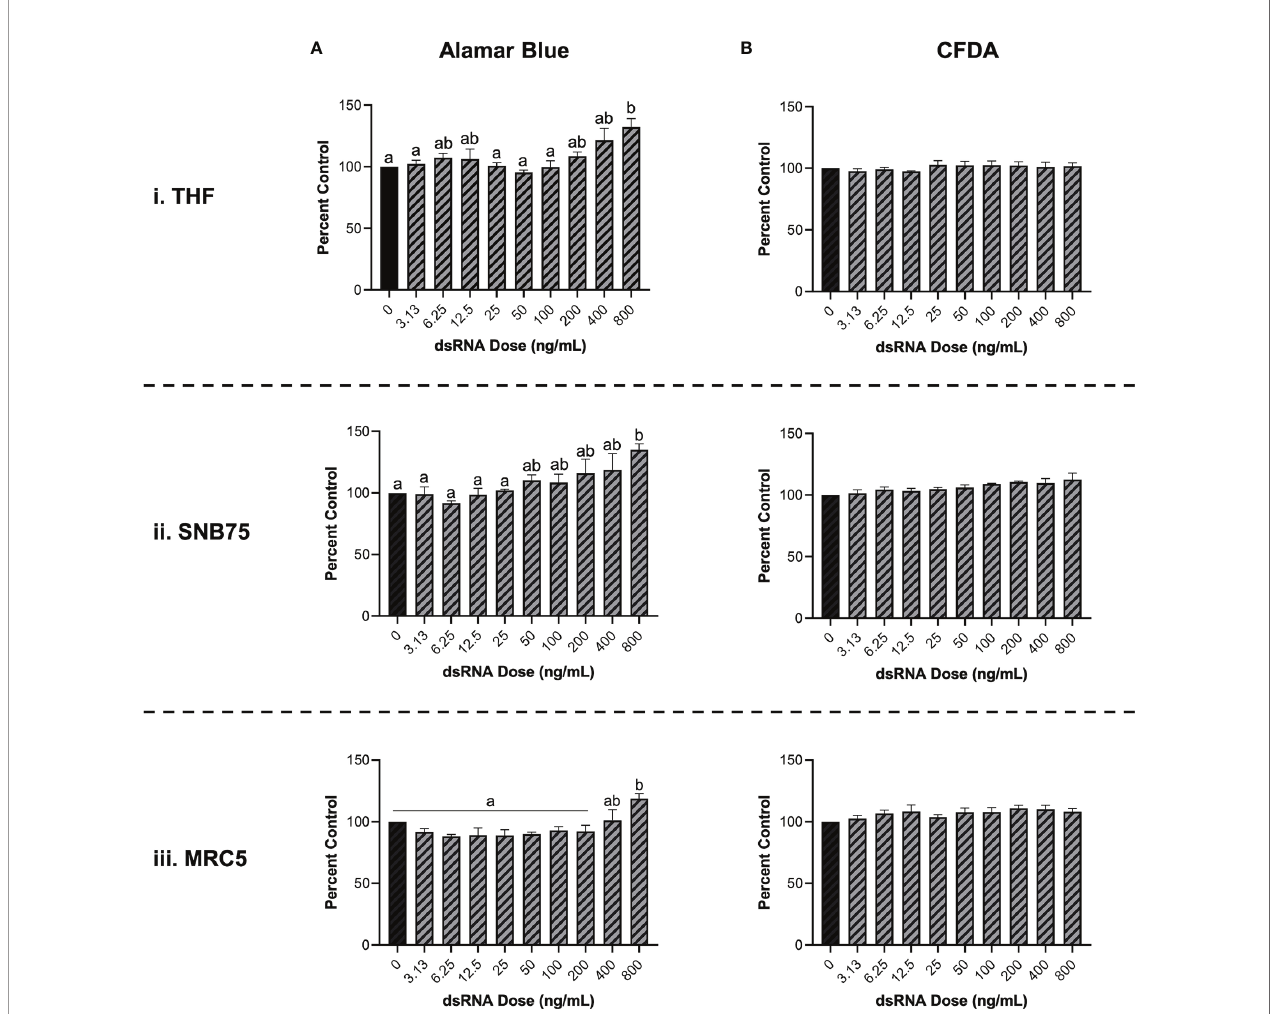
FIGURE 2 | Soaking cells with long dsRNA does not negatively in fl uence cell viability. THF (i) , SNB75 (ii) and MRC5 (iii) were soaked with 700 bp dsRNA for 26h at concentrations that ranged from 0 ng/mL to 800 ng/mL. Cellular metabolism was measured using an Alamar Blue assay (A) and membrane integrity was measured using CFDA (B) . Error bars represent +SEM, and each data point represents the average of 3 independent experiments. A p-value of less than 0.05 was considered to be statistically signi fi cant. Error bars with different letters represent signi fi cantly different